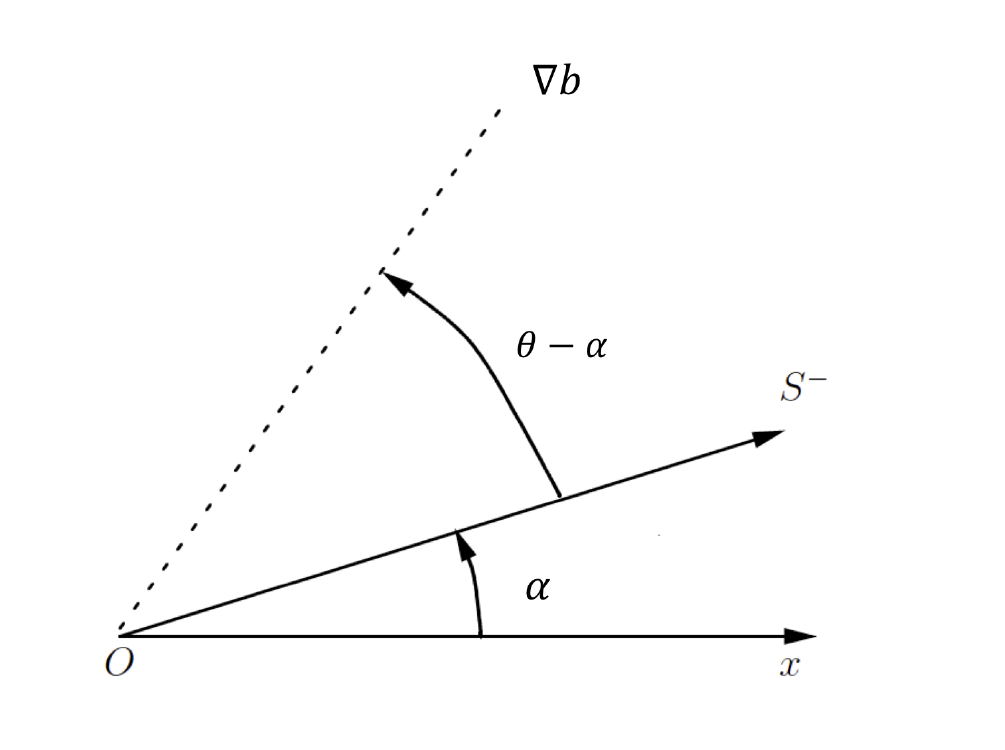
Figure A1. θ is the angle between ∇ b and the x -axis and α is the angle between the compressional strain vector ( S − ) and the x